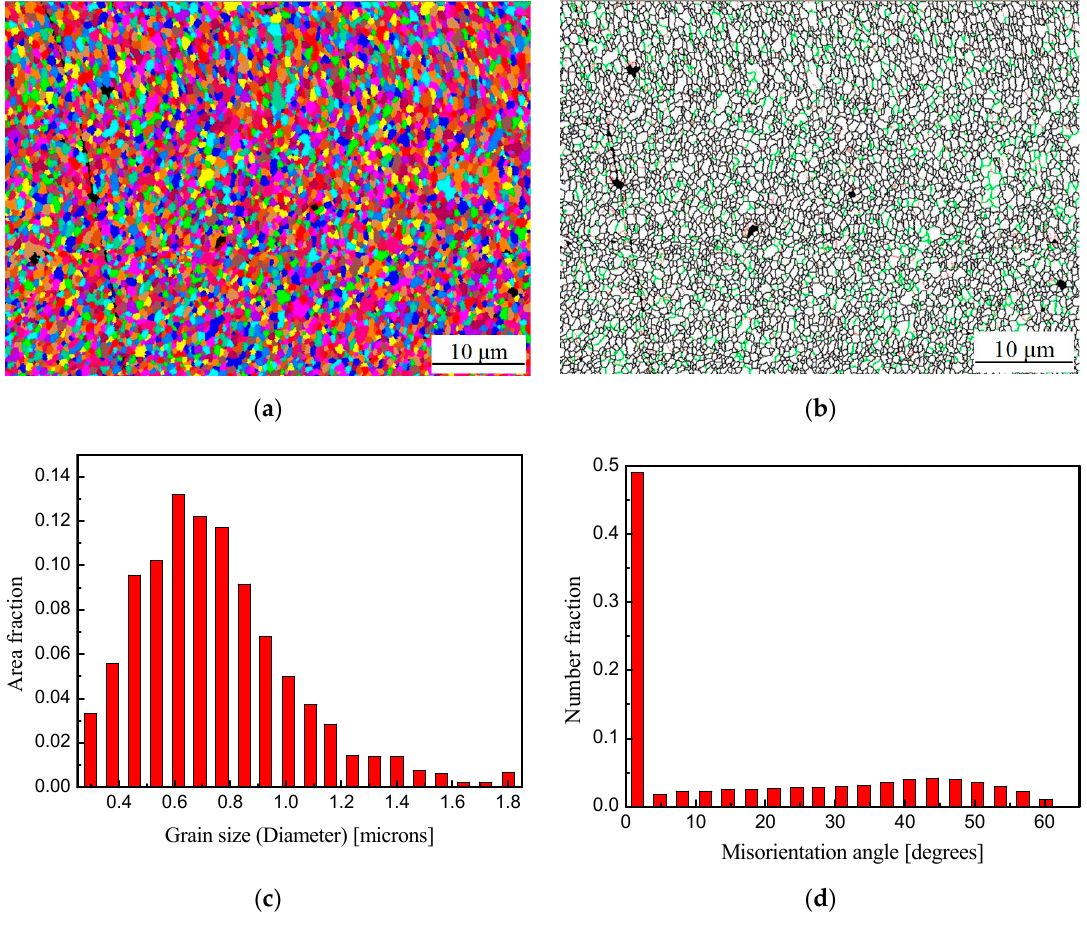
Figure 10. EBSD analysis of stir zone using process parameters: rotating speed 400 rpm, plunge rate 18 mm/min, plunge depth 2.2 mm, and dwell time 3 s: ( a ) grain shape; ( b ) EBSD boundary map; ( c ) area fraction of grain size; ( d ) number fraction of misorientation angle.